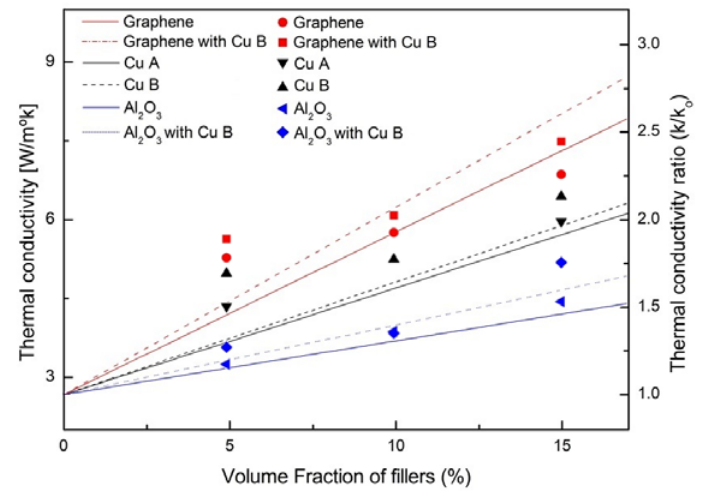
Figure 8. Result of thermal conductivity measurement and thermal conductivity ratio each case.